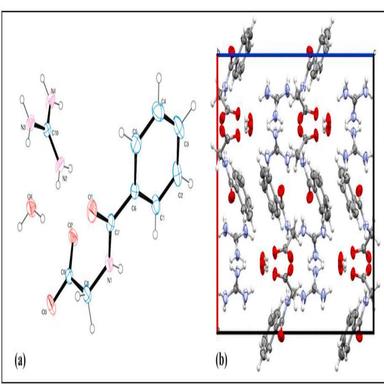
(a) ORTEP of GuHM (b) Crystal packing of GuHM along b axis.